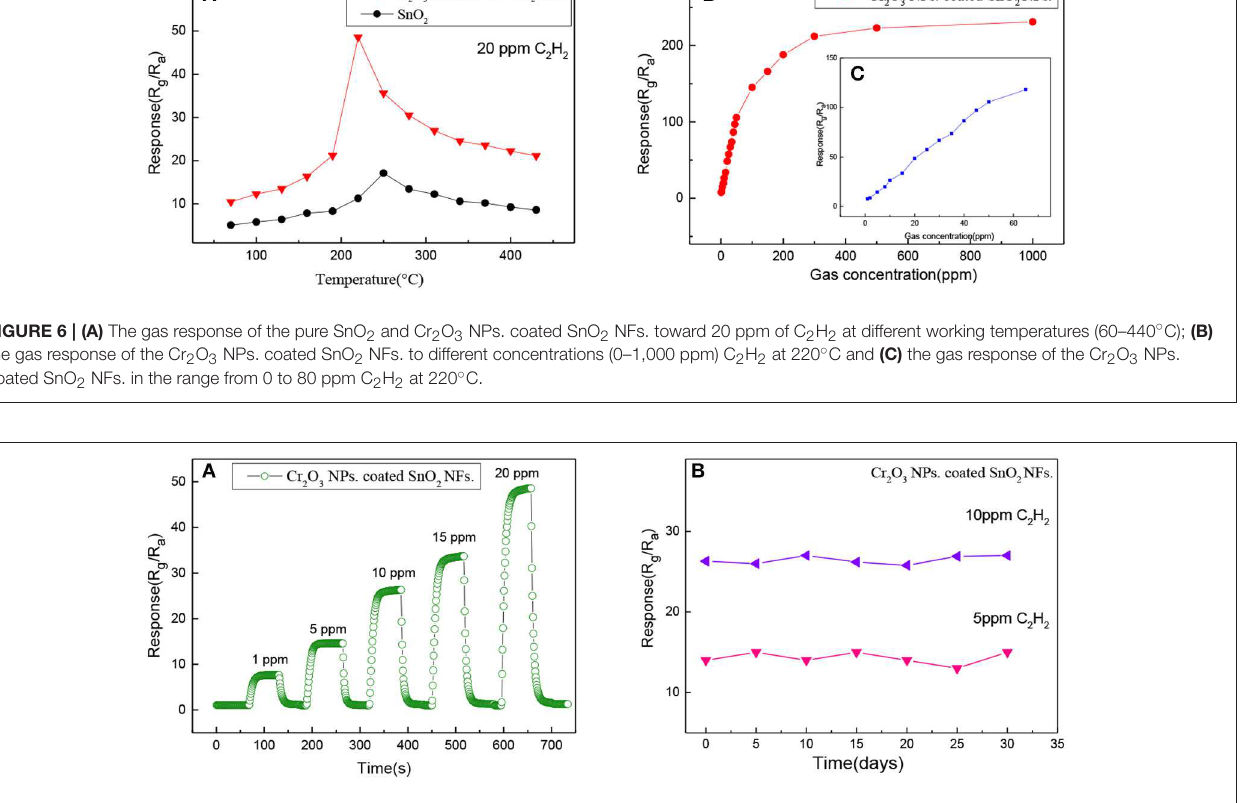
FIGURE 7 | (A) The dynamic response-recovery characteristic of Cr 2 O 3 NPs. coated SnO 2 NFs. sample at different concentrations (1, 5, 10, 15, 20 ppm) at optimal operating temperature and (B) the long-term stability of Cr 2 O 3 NPs. coated SnO 2 NFs to 5 and 10 ppm C 2 H 2 at 220 ◦ C.